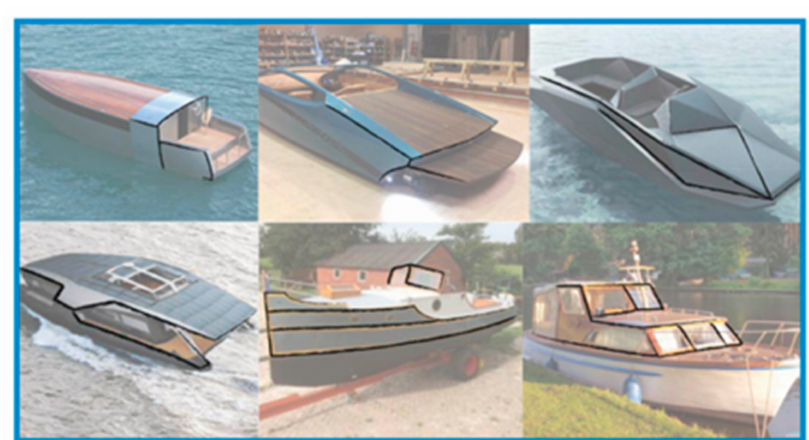
Figure 6. Stone Style Examples.